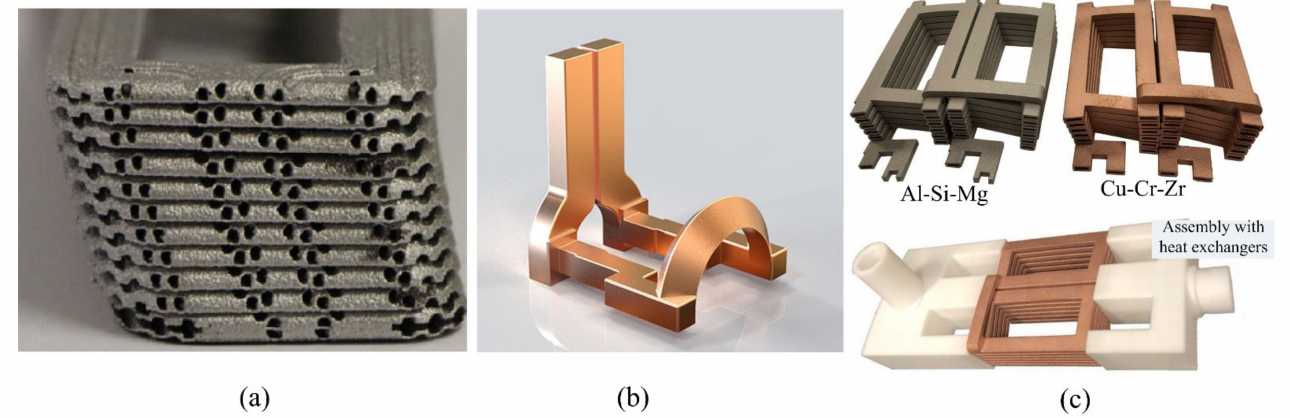
Figure 17. AM coils integrated with cooling channels. ( a ) Concentrated aluminum alloy coil [68]; ( b ) Induction heating coil [69]; ( c ) hollow conductors